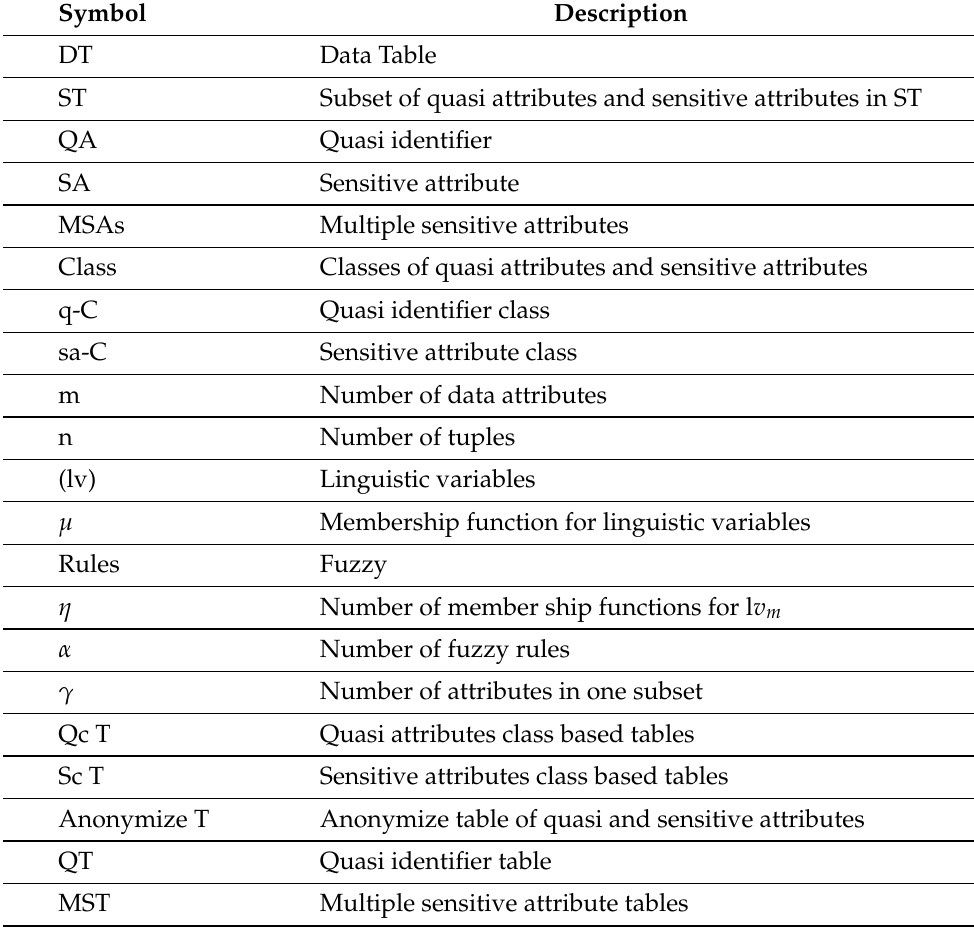
Table 6. Summary of